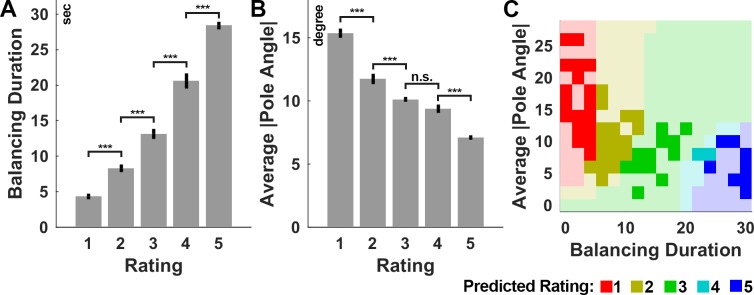
Analysis of subjects’ ratings during visual familiarization.(A) Balancing duration and (B) average absolute pole angle as function of subjects’ ratings. Data shown are the averages (bar) ± 1 S.E.M. expressing the between-subject variability. (C) Predicted rating of the fitted multinomial log-linear model as function of balancing duration and average absolute pole angle fitted to subjects’ responses. The model prediction was sampled uniformly in both dimensions for visualization. Opacity indicates whether training samples are close. Notice, that the rating (color) depends on both parameters, balancing duration and average absolute pole angle. *** p<0.001, n.s. p>0.1.